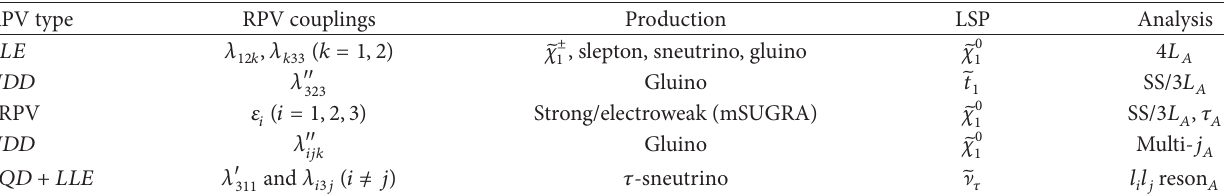
Table 2: Schematic overview of RPV model parameters investigated by ATLAS analyses. The signature descriptions are also indicated in Table 1 with corresponding